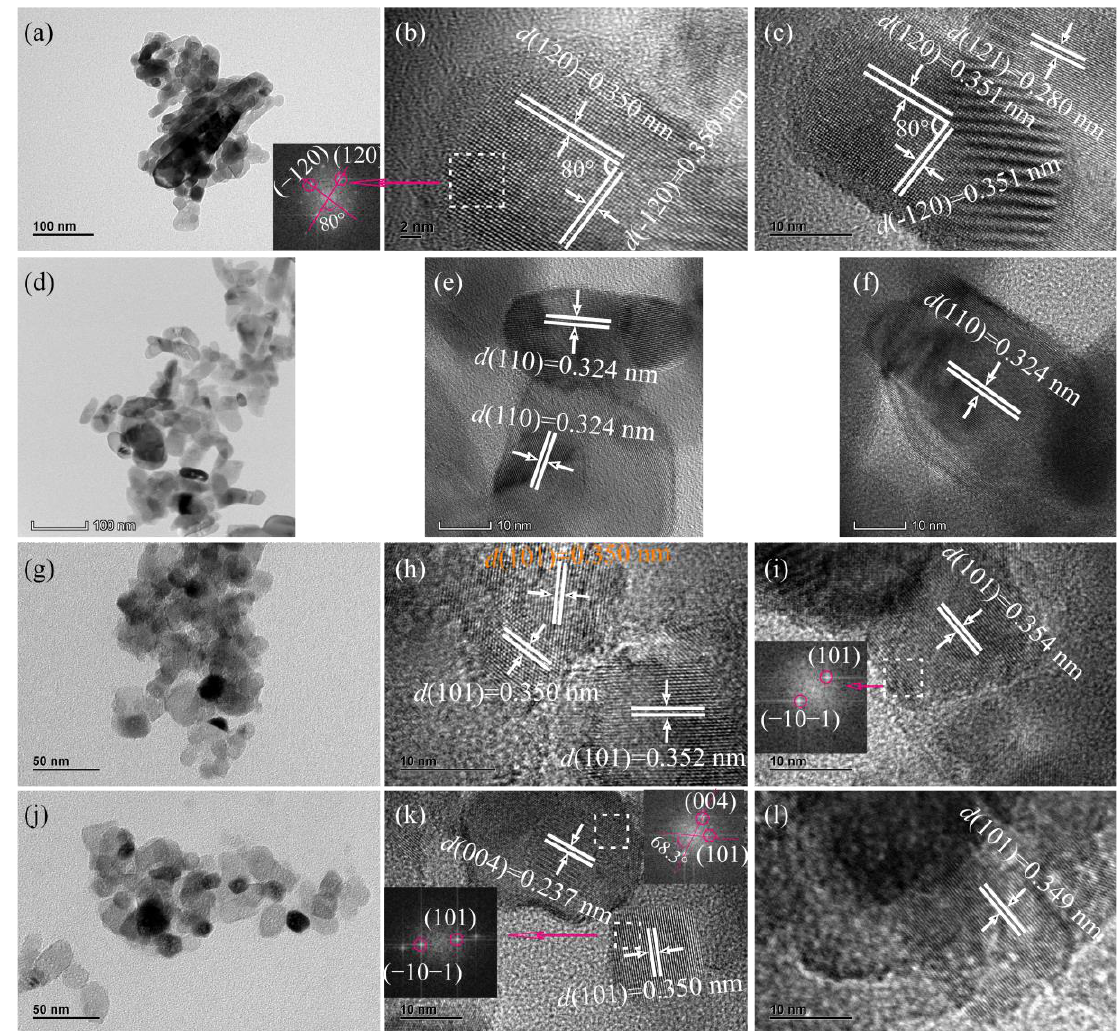
Figure 3. TEM and HRTEM images of the prepared ( a – c ) pH0.5 − T500 − TiO 2 , ( d – f ) pH1.5 − T500 − TiO 2 , ( g – i ) pH3.5 − T500 − TiO 2 and ( j – l ) pH5.5 − T500 − TiO 2 samples under different pH value conditions. The insets in ( a , i , k ) are fast Fourier transform (FFT) diffraction